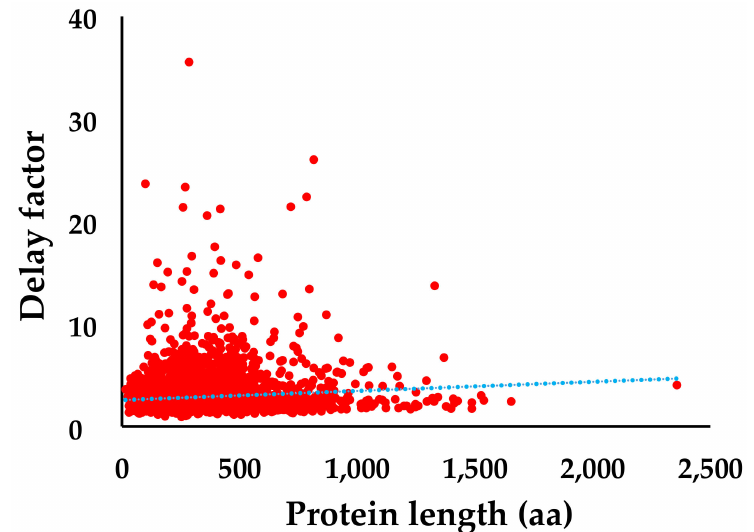
Figure 2. The effects of protein length on cell growth. The delay factor and protein length of individual ASKA collection strains were plotted with red color. The blue dot line is the trend